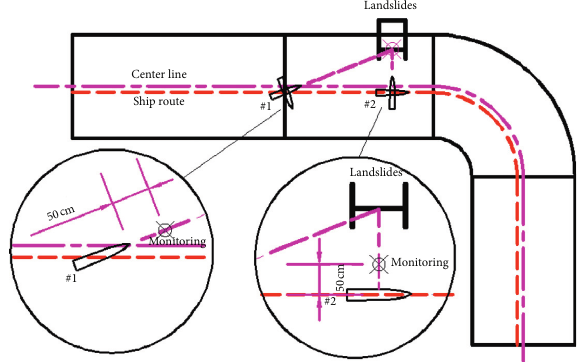
Figure 13: Schematic diagram of ship precontrol research scheme.